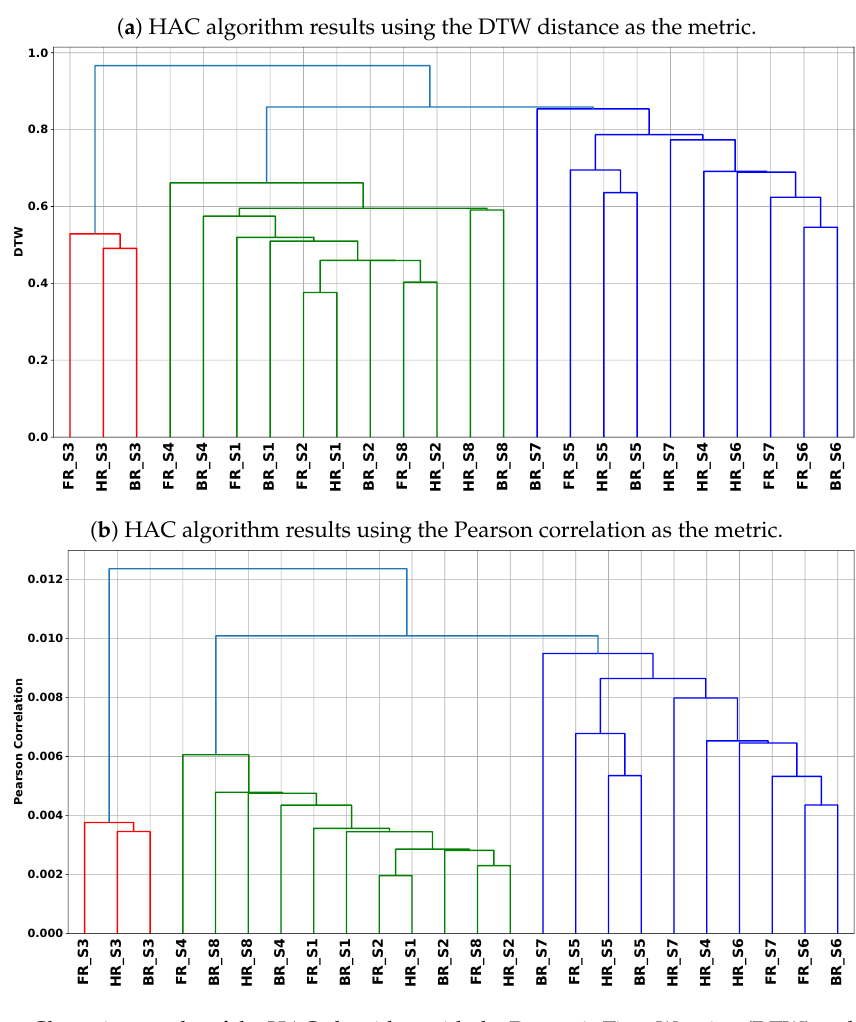
Figure 7. Clustering results of the HAC algorithm with the Dynamic Time Warping (DTW) and Pearson correlation metrics. Table 4. Clustering results using the Dynamic Time Warping (DTW) and Pearson correlation